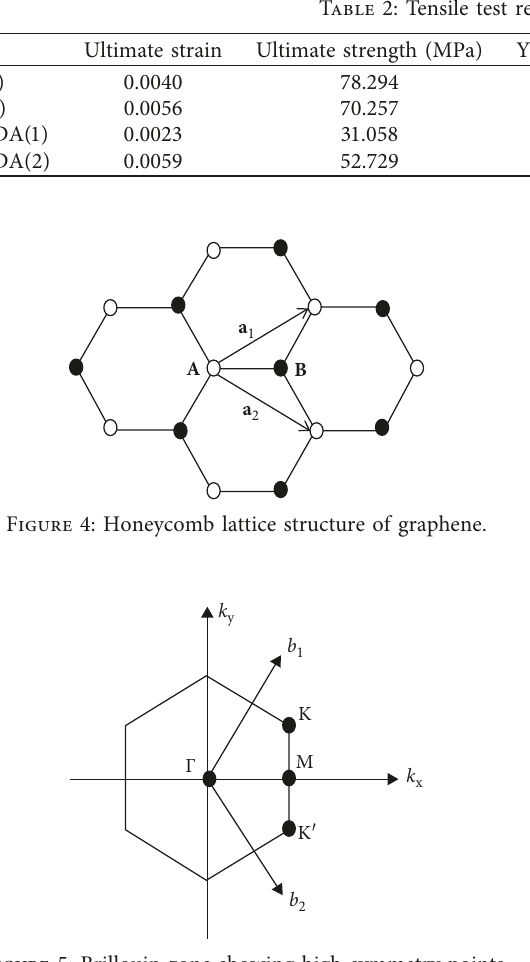
Figure 5: Brillouin zone showing high-symmetry points.